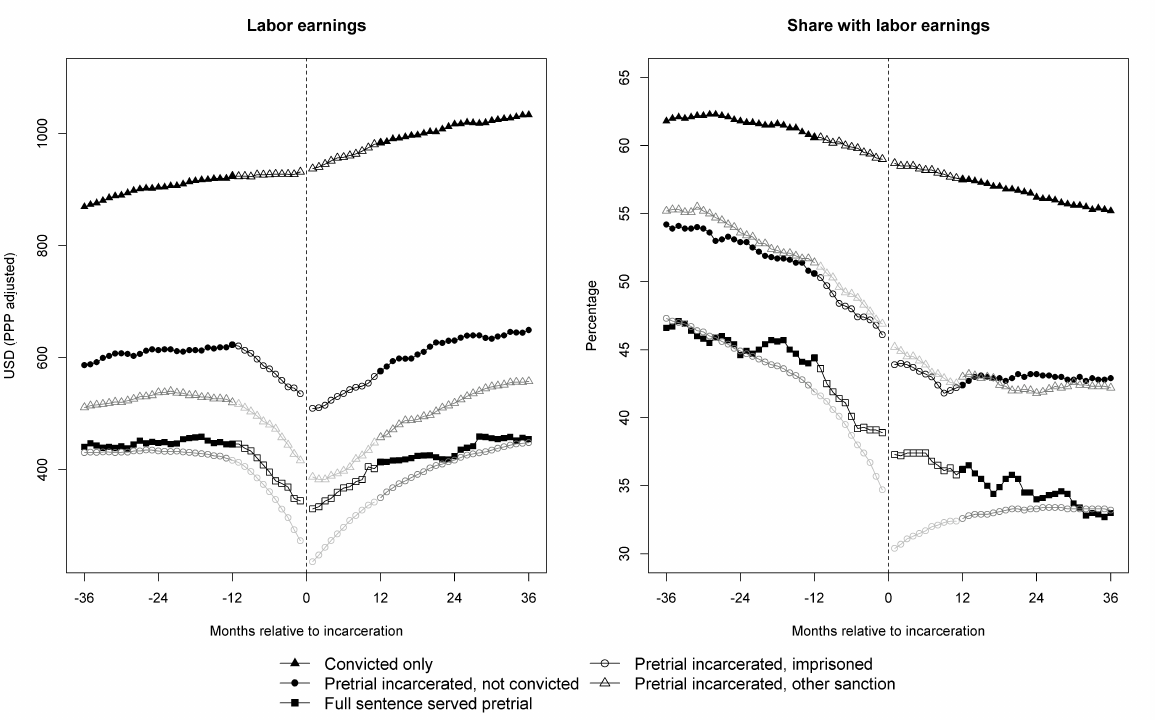
. Figure 1: Labor market outcomes before and after incarceration or conviction. Men, Denmark, 1995 to 2010. N = 75,187. Labor earnings measured in 2010 OECD individual consumption PPP adjusted USD. Labor earnings are uncertain during the last 11 months before admission/conviction and during the first 11 months following release/conviction because they are derived from annual labor earnings. In our estimation results we exclude these uncertain data